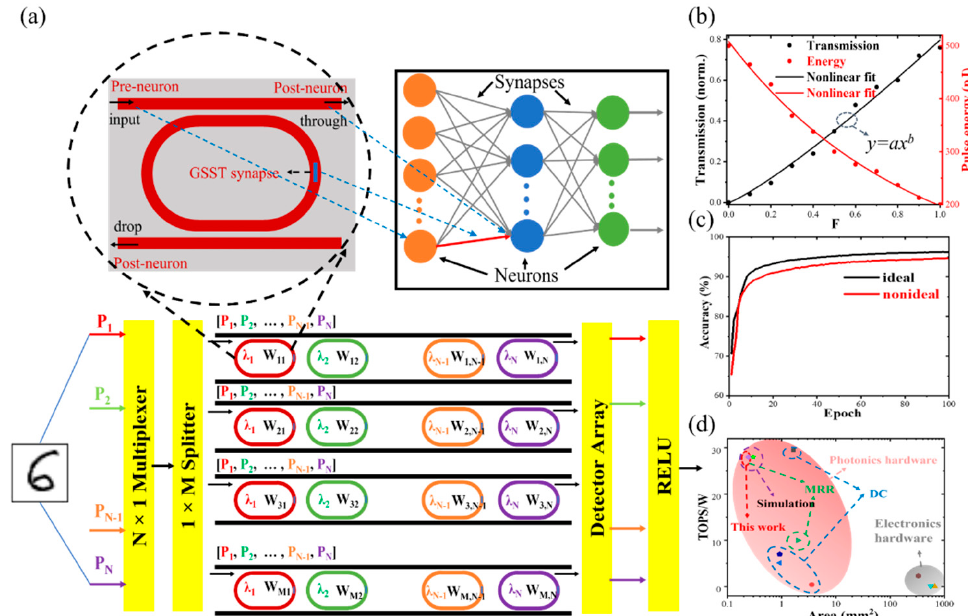
Figure 7. ( a ) Schematic diagram of the device for neural networks. ( b ) Through-port transmittance and energy as a function of crystallization levels F (where a = 0.8, b = 1.18). ( c ) Accuracy on MNIST dataset using ideal characteristics and nonideal characteristics of the GSST-slot racetrack resonators. ( d ) Comparison of footprint and computing energy efficiency between this work and previously reported devices including microring resonator (MRR) and directional coupler (DC).